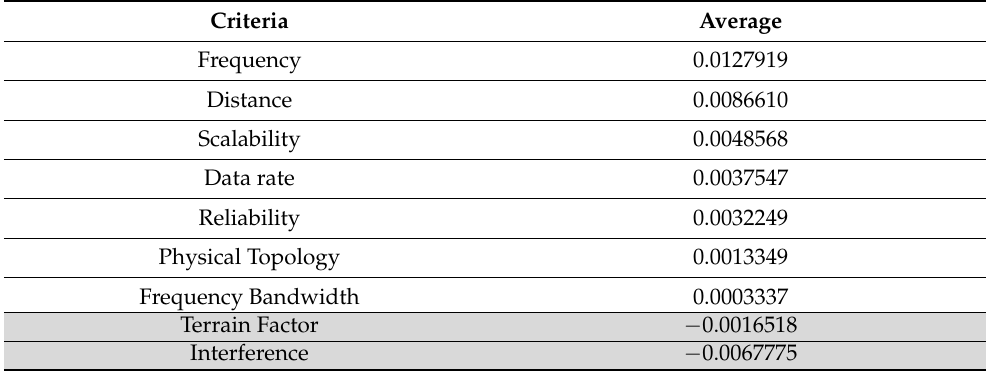
Table 6. Ranked technical criteria based on the average values of the output of the ‘Explain Predic- tion’